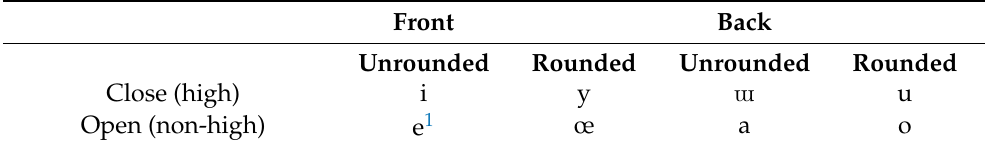
Figure 2. Standard Istanbul Turkish vowels according to Zimmer and Orgun (1992). Table 1. Turkish vowel contrasts presented according to height, backness, and rounding (adapted from Sabev 2019).